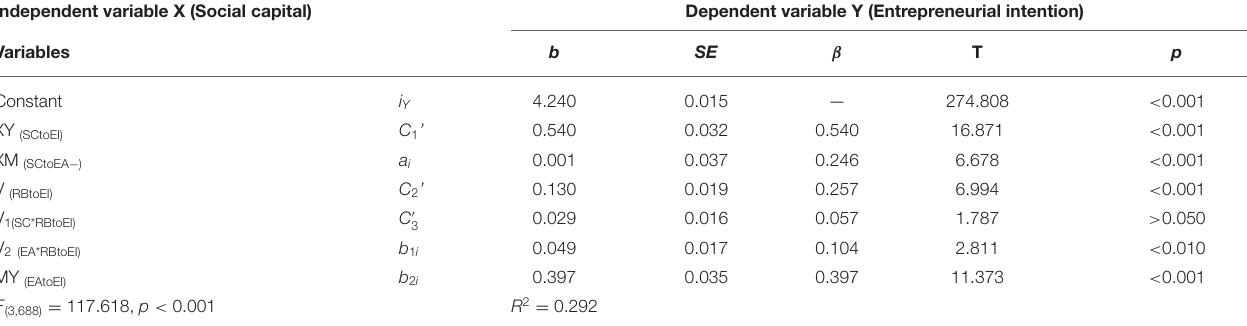
TABLE 5 | The moderating effect estimated result summary ( n = 692). Independent variable X (Social capital)